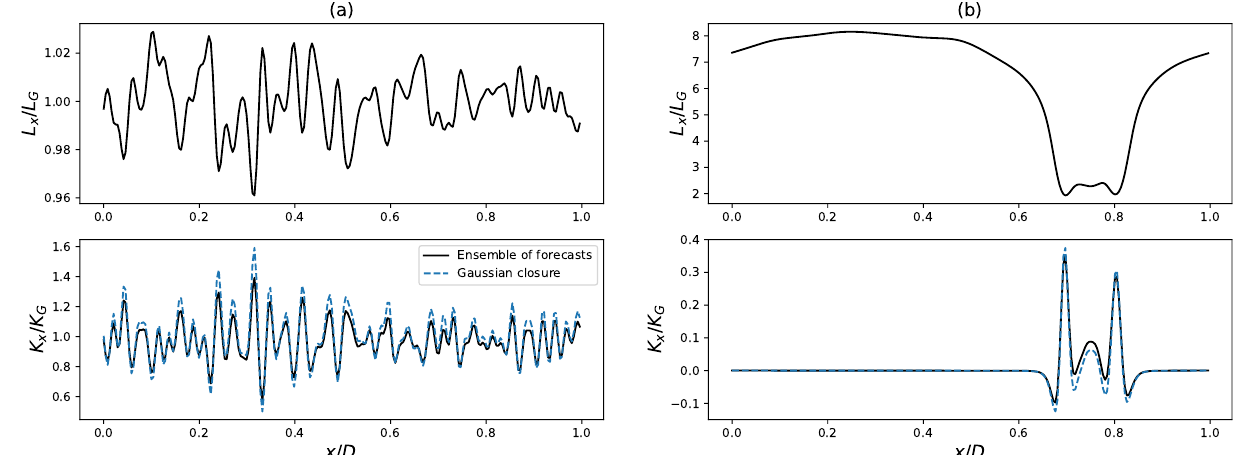
g 2 (bottom panels) G 8